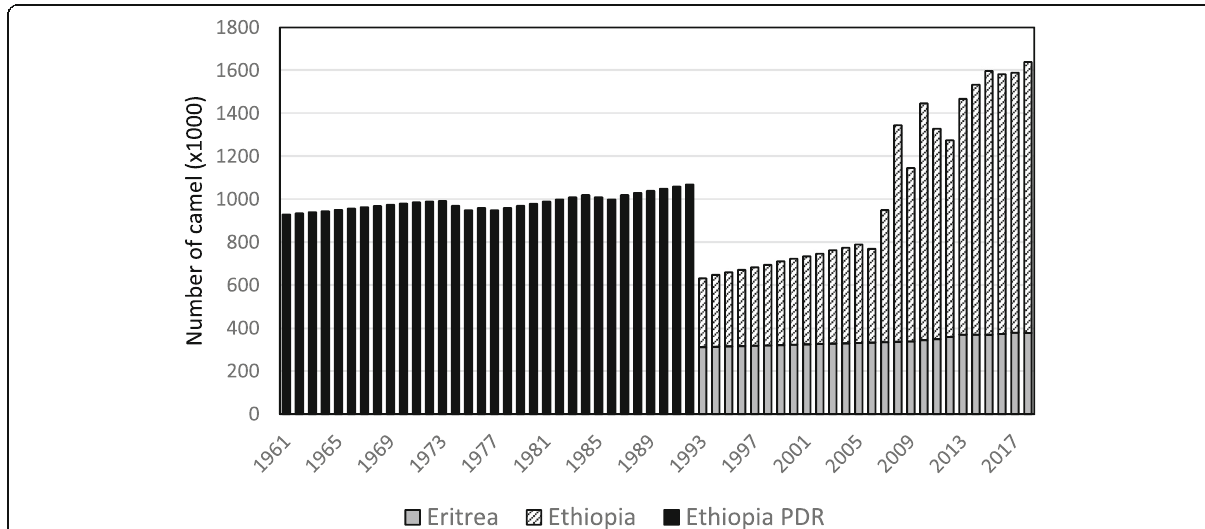
Fig. 15 Changes in camel stock in Ethiopia PDR (1961 – 1992) and in the sum Ethiopia + Eritrea (1993 – 2018) according to the FAOstat